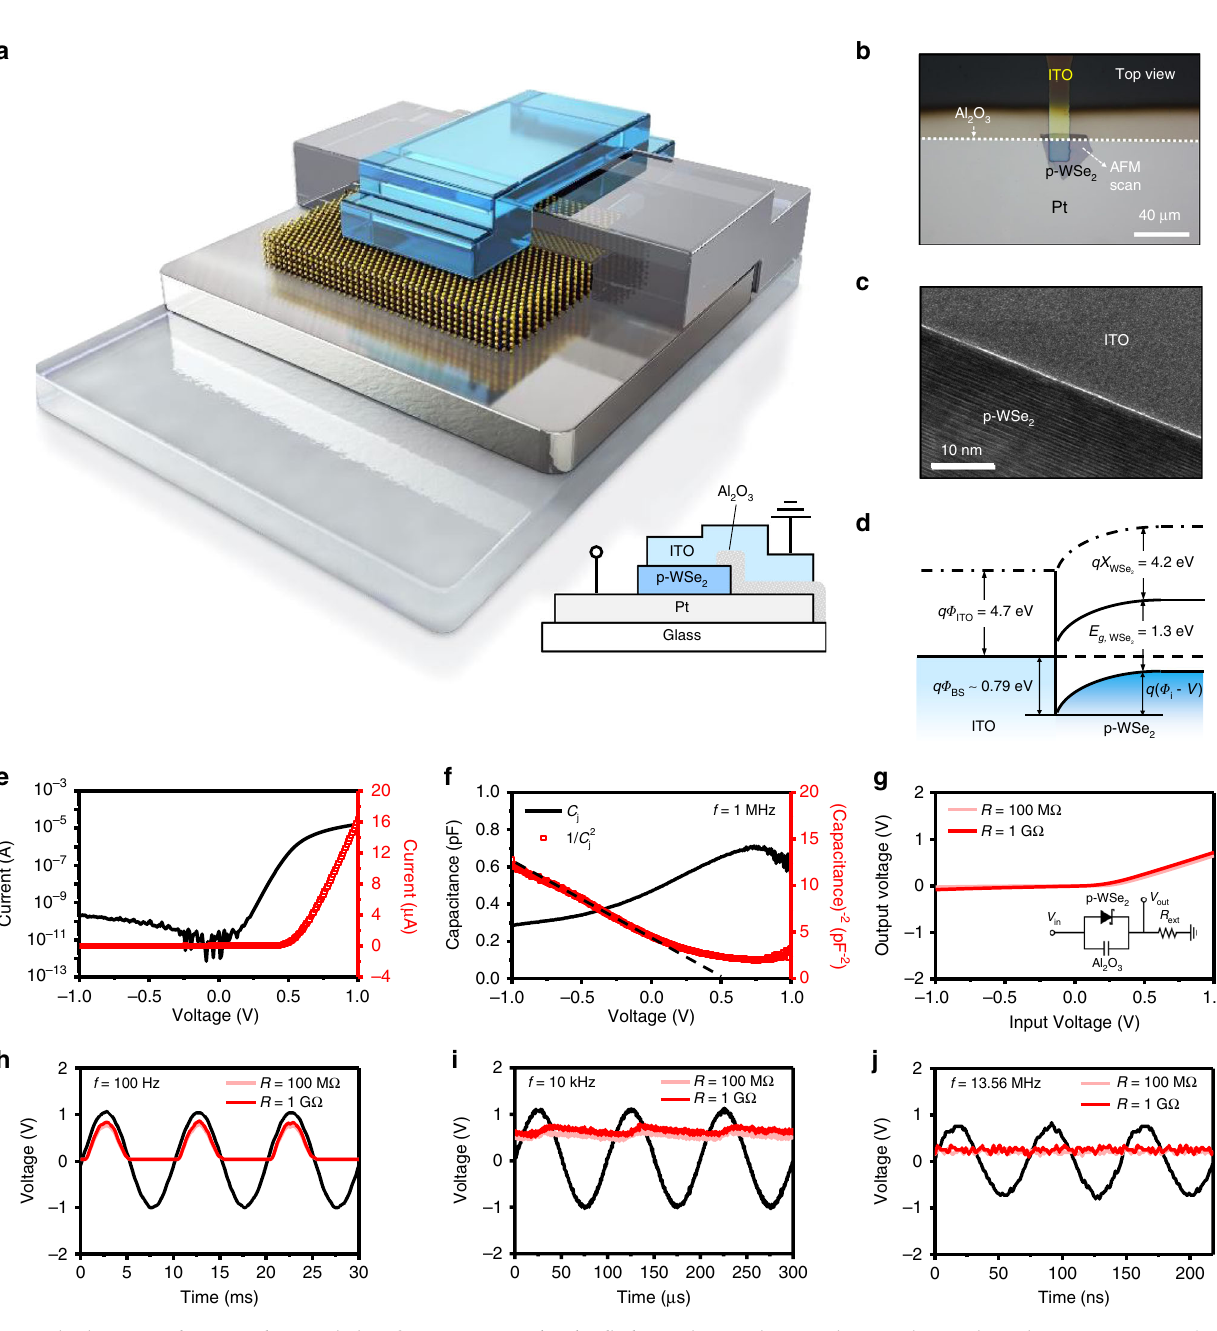
Fig. 1 Device images and DC/AC characteristics of ITO/p-WSe 2 Schottky diode. 3D device schematic diagram along with 2D device cross section (inset) ( a ) and OM image ( b ) of a vertical ITO/p-WSe 2 Schottky diode. Cross-sectional TEM image ( c ) and band diagram ( d ) of ITO/p-WSe 2 Schottky junction. I – V ( e ) and C j – V or 1/ C j 2 – V ( f ) characteristics of the ITO/p-WSe 2 Schottky diode through which WSe 2 thickness could be worked out to be 50.5 nm, which appears well matched to the results from AFM thickness pro fi les (Supplementary Fig. 6). g Static V in – V out curve was obtained by sweeping V in from − 1 to + 1 V, along with the inset device circuit where external resistance of 100 M Ω and 1 G Ω is used. Observation of half-wave recti fi cation in V – V in (black) out (red) plots obtained from the diode circuit with a parallel capacitor at 100 Hz ( h ), 10 kHz ( i ), and 13.56 MHz ( j AM demodulation for radio reception . We demonstrate suc- Figure 2b, c presents the time domain signals of AM input voltage cessful demodulation of AM radio signals using the Schottky (black band) overlaid with demodulated DC output voltage sig- diode. The dashed square part including antenna was simulated nals (red line with 0.17 V peak) that, respectively, result from two by using a function generator, and the Schottky diode integrated cases of frequency mixing [( f m , f c ) = (0.5 kHz, 1.5 MHz) and (1 kHz, 1.5 MHz)]. AM input voltage signals appear well demodu- with a parallel capacitor and an external series resistor served as lated in overall view with a slight phase shift for 1 kHz signal as the main components of the demodulator (Fig. 2a). Carrier fre- shown in Fig. 2c. The 1.5 MHz AM input voltage band appears quencies ( f c ) of 500 kHz, 1 MHz, and 1.5 MHz and the low modulating frequencies ( f m ) of 0.5, 1, and 5 kHz were selected for just black and unresolved in our display due to too many AC audio signal frequencies at a modulation index of 100% 43 . oscillations in a band (but such an input band could be resolved